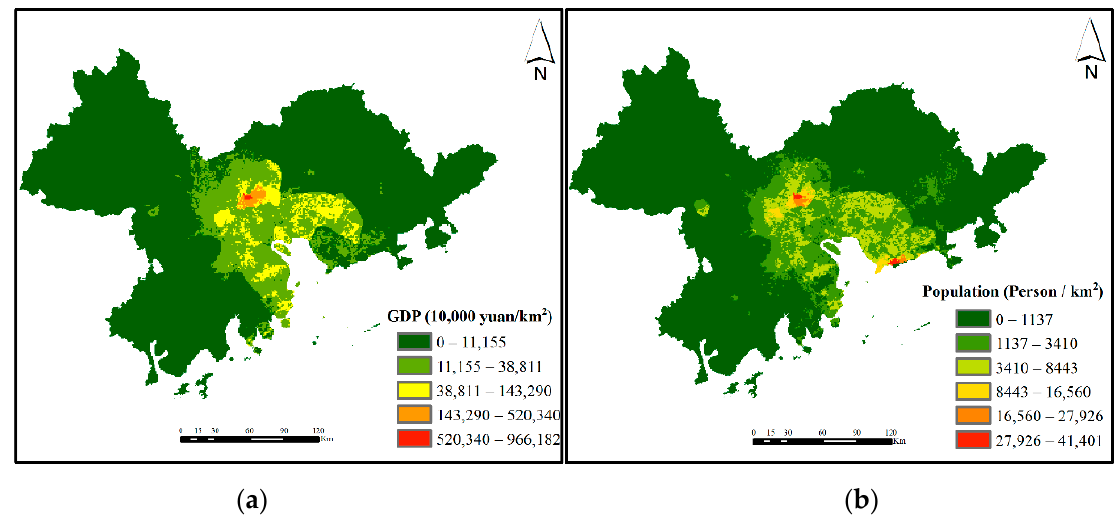
Figure 3. Gridded GDP and population in the PRD region: ( a ) Gridded GDP in PRD, ( b ) Gridded Population in PRD.